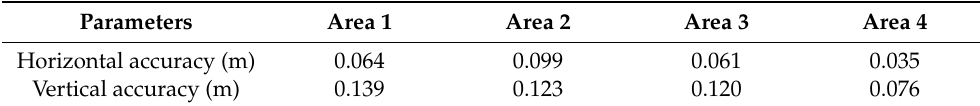
Table 5. Horizontal and vertical absolute accuracy of the